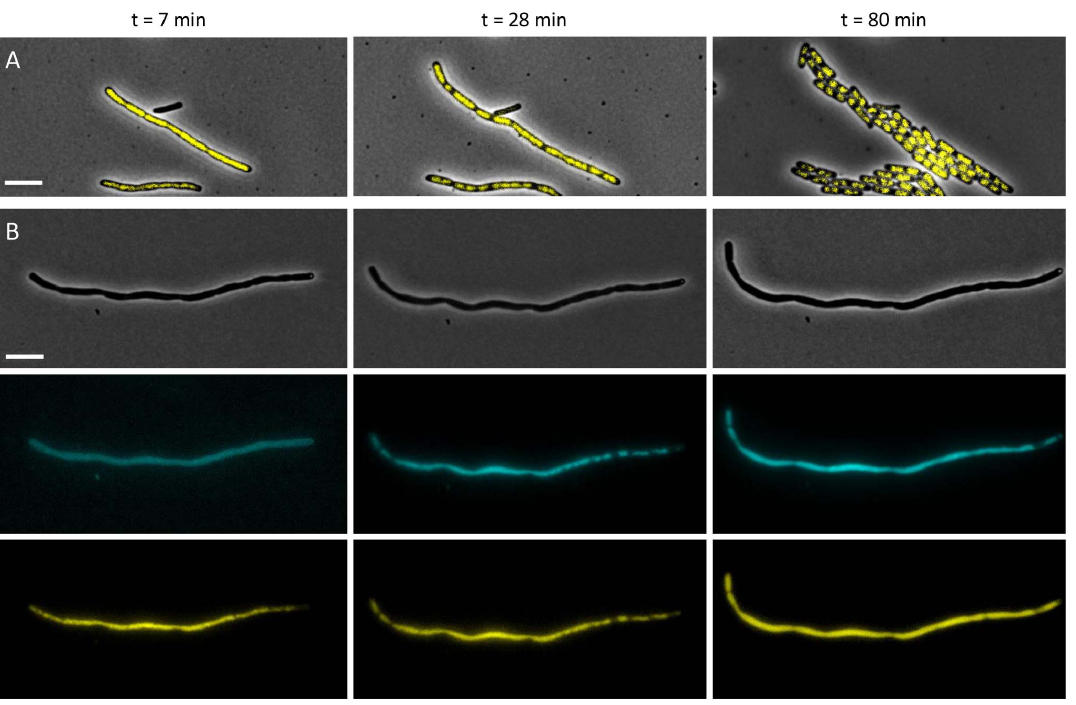
Figure 4. Growth and nucleoid dynamics of HP stressed LT2. (A) Representative images showing cell growth and nucleoid dynamics of HP stressed LT2 iscR :: yfp cells (grown overnight at 40–45 MPa and 37 u C) at the indicated time points after pressure release. Merged phase contrast and YFP images are shown. (B) Representative images showing cell growth and nucleoid dynamics of a HP stressed LT2 iscR :: yfp cell (grown overnight at 40–45 MPa and 37 u C) at the indicated time points after pressure release in the presence of DAPI and intermittent UV excitation. Phase contrast (top panels), DAPI (middle panels) and YFP (lower panels) images are shown. Scale bars correspond to 5 m m.